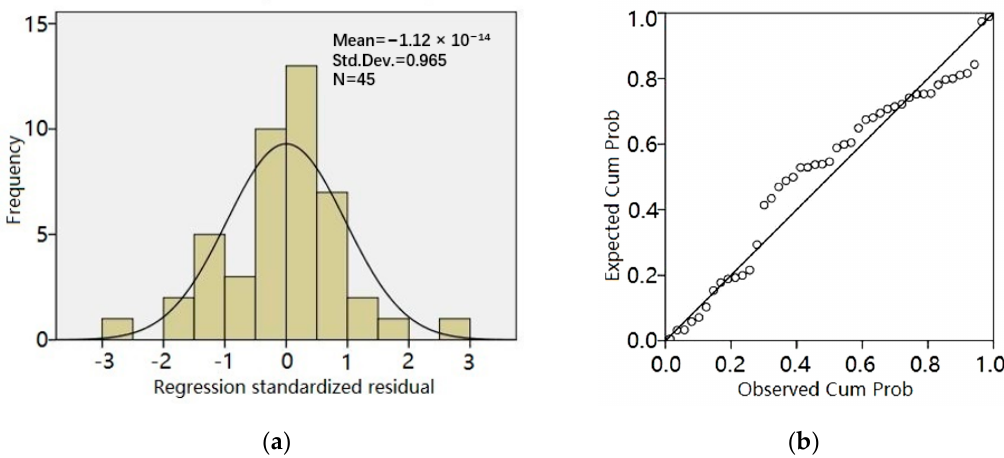
Figure 2. The results based on the enter method: ( a ) the residual frequency distribution histogram and ( b ) the residual normal probability plot . ( b ) the residual normal probability